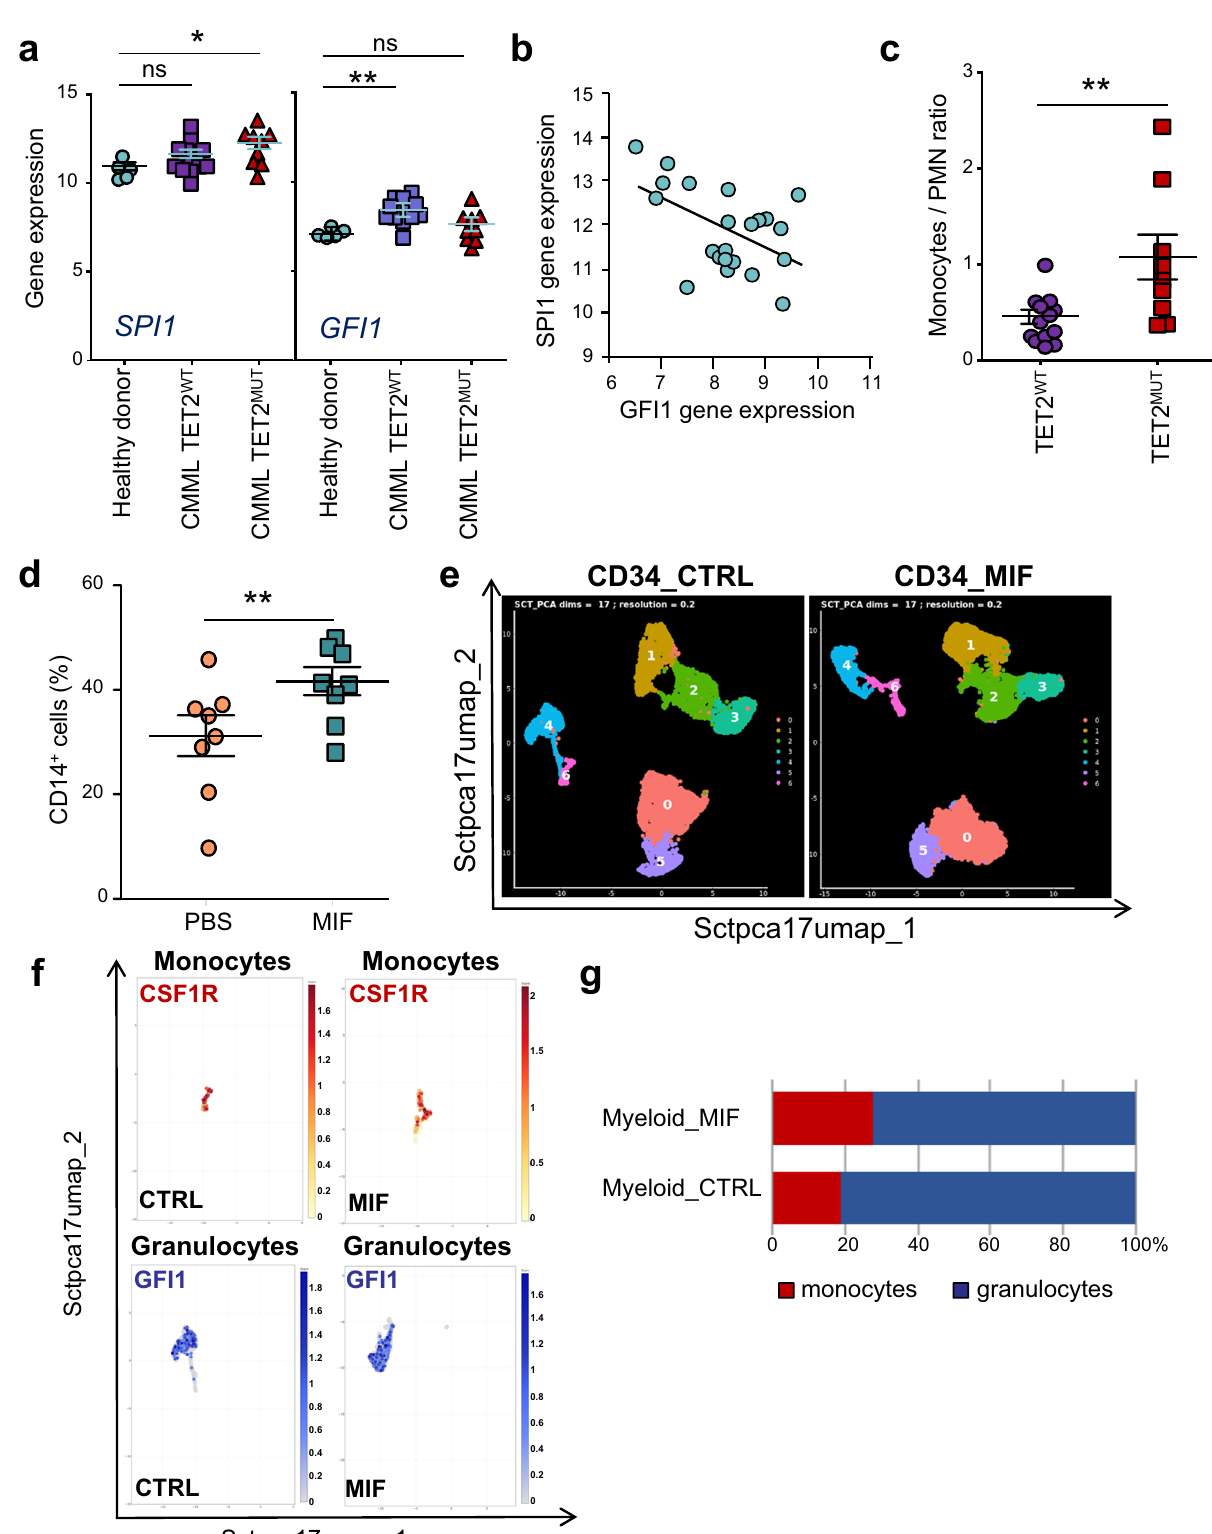
Methods In vitro granulo-monocyte differentiation . Umbilical cord blood samples were collected from healthy newborns with mother consent: AP-HP, Hôpital Saint- Louis, Unité de Thérapie Cellulaire, CRB-Banque de Sang de Cordon, Paris, France – N° d ’ autorisation: AC-2016-2759. Sorted CD34 + cells, using magnetic beads and AutoMacs system (Miltenyi Biotech), were depleted for TET2 and subjected to monocyte/macrophage differentiation as previously described 48 . Supernatants were